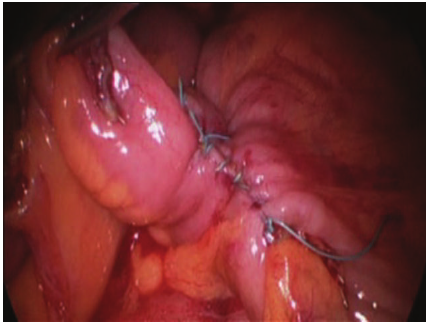
Figure 2: Total intracorporeal anastomosis